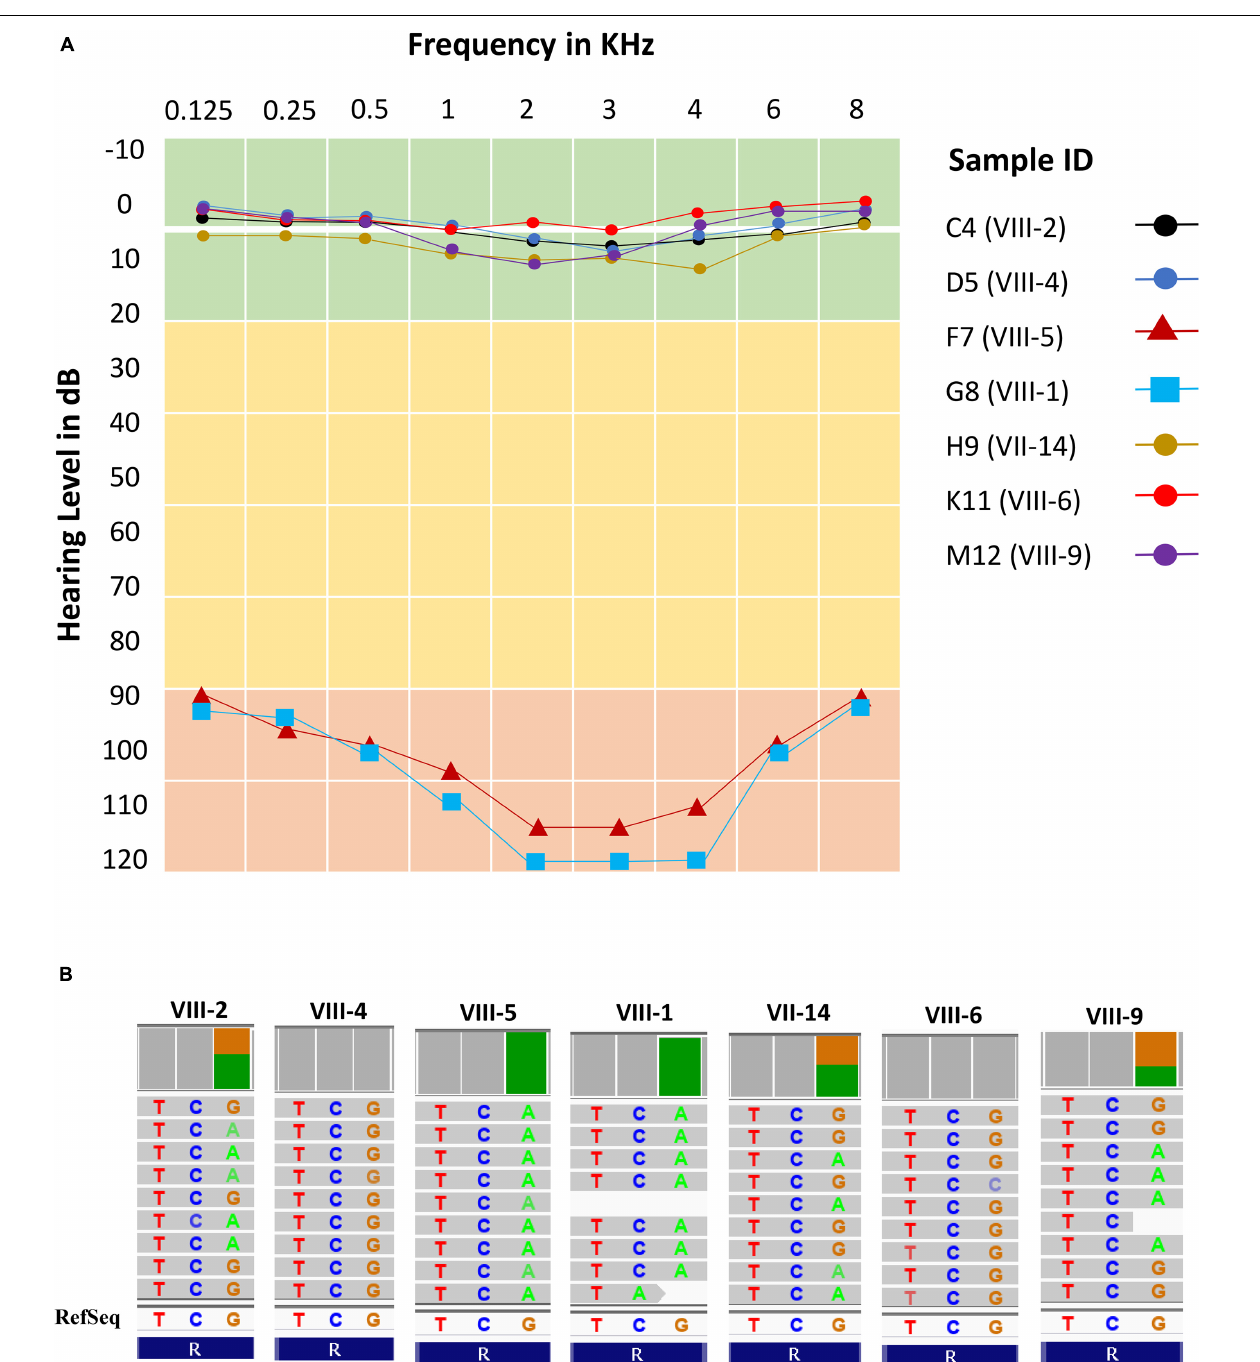
FIGURE 3 | Audiometric characteristics and whole exome data. (A) Audiometric data shows five normal hearing subjects (levels between 0 and 10 dB) and two cases (levels > 90 dB) for all frequencies (KHz). (B) Whole exome data reflects exactly the phenotypic data with two homozygous cases (F7 and G8), three heterozygous normal (C4, H9, and M12) and two normal with homozygous reference allele (D5 and K11).